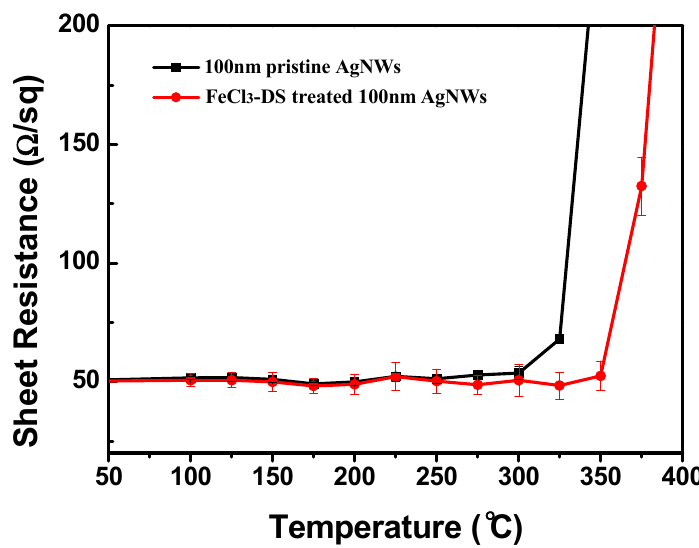
Figure 7. Sheet resistance variation of AgNW TCFs of 100 nm-thick AgNWs in the thermal test: pristine AgNWs (blank line) and AgNWs treated with 0.042 mM FeCl 3 -DS for 120 min (red line).